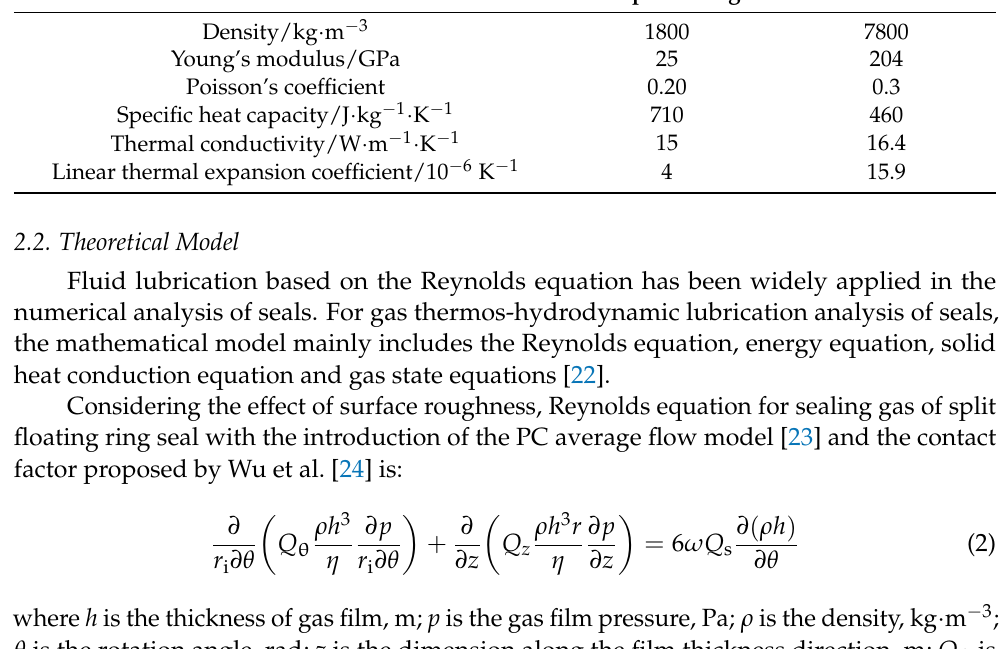
Table 2. Characteristics of the materials [22]. Item Graphite Ring Runner Density/kg · m −